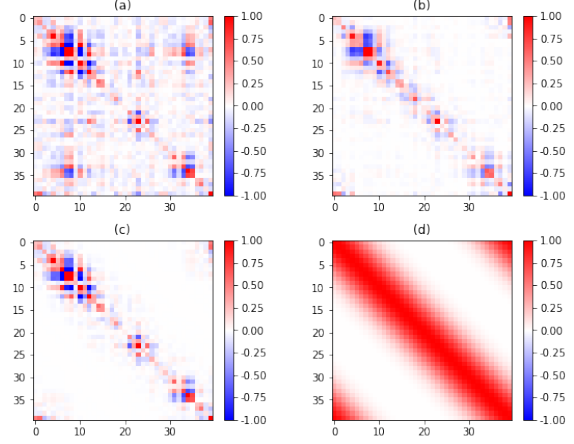
Figure 5. Representations of the covariance matrix estimated by ( a ) 20 members, ( b ) 100 members, ( c ) 20 members with localization. And ( d ) the localization